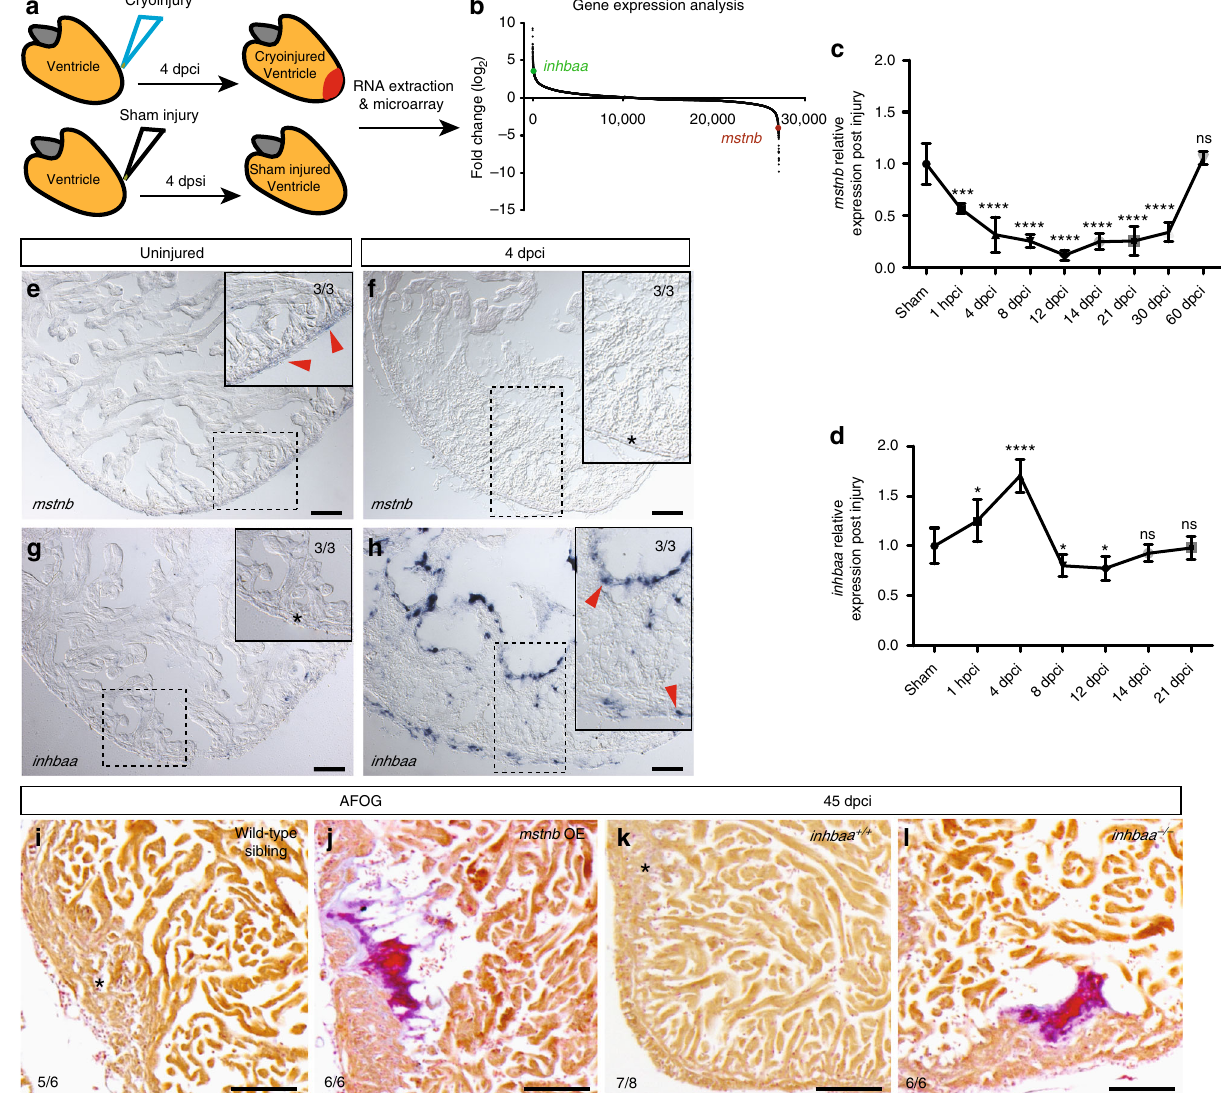
Fig. 1 mstnb and inhbaa have opposing response and functions during zebra fi sh cardiac regeneration. a Schematic representation of injury and sample preparation for microarray analysis ( n = 12 hearts). b Averaged transcriptional gene expression changes post cryoinjury as assessed by microarray analysis ( inhbaa and mstnb indicated). c , d Temporal RT-qPCR analysis for mstnb and inhbaa expression post cryoinjury ( n = 2 × 3 cardiac ventricles assessed as two biological and two technical replicates for each time point, data are mean ± s.e.m., ns: no signi fi cant changes observed, * P ≤ 0.05, *** P ≤ 0.001, and **** P ≤ 0.0001 — Student ’ s t test, two-tailed). e – h In situ hybridization for mstnb and inhbaa expression on uninjured and 4 dpci adult zebra fi sh heart sections. Higher magni fi cations of dashed boxes in e – h are shown in upper right corners. RNA probe signal is indicated by red arrowheads and the absence of signal is indicated by asterisks. The numerators indicate the number of hearts with a particular pattern of signal, and the denominators the total number of hearts analyzed. i – l AFOG staining of sections from wild-type sibling, mstnb OE, inhbaa + / + , and inhbaa − / − cryoinjured hearts at 45 dpci. Healthy myocardium in orange, fi brin in red, collagen in blue. Asterisks indicate the regions of resolved scarring. The numerators indicate the number of hearts with a particular pattern of scarring, and the denominators the total number of hearts analyzed. Scale bars: in situ hybridization images, 50 µ m; AFOG staining images, 100